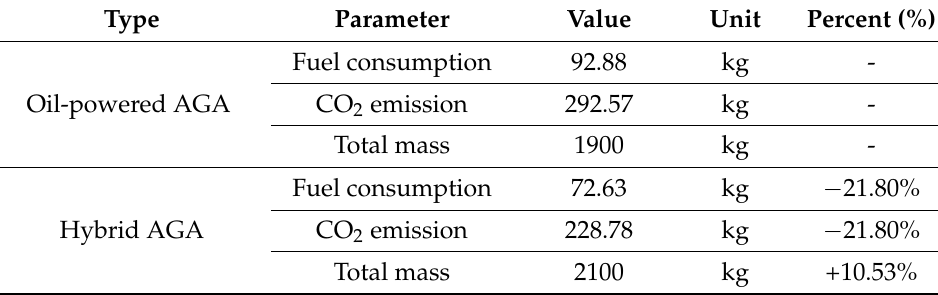
Table 6. Total performance parameters of the